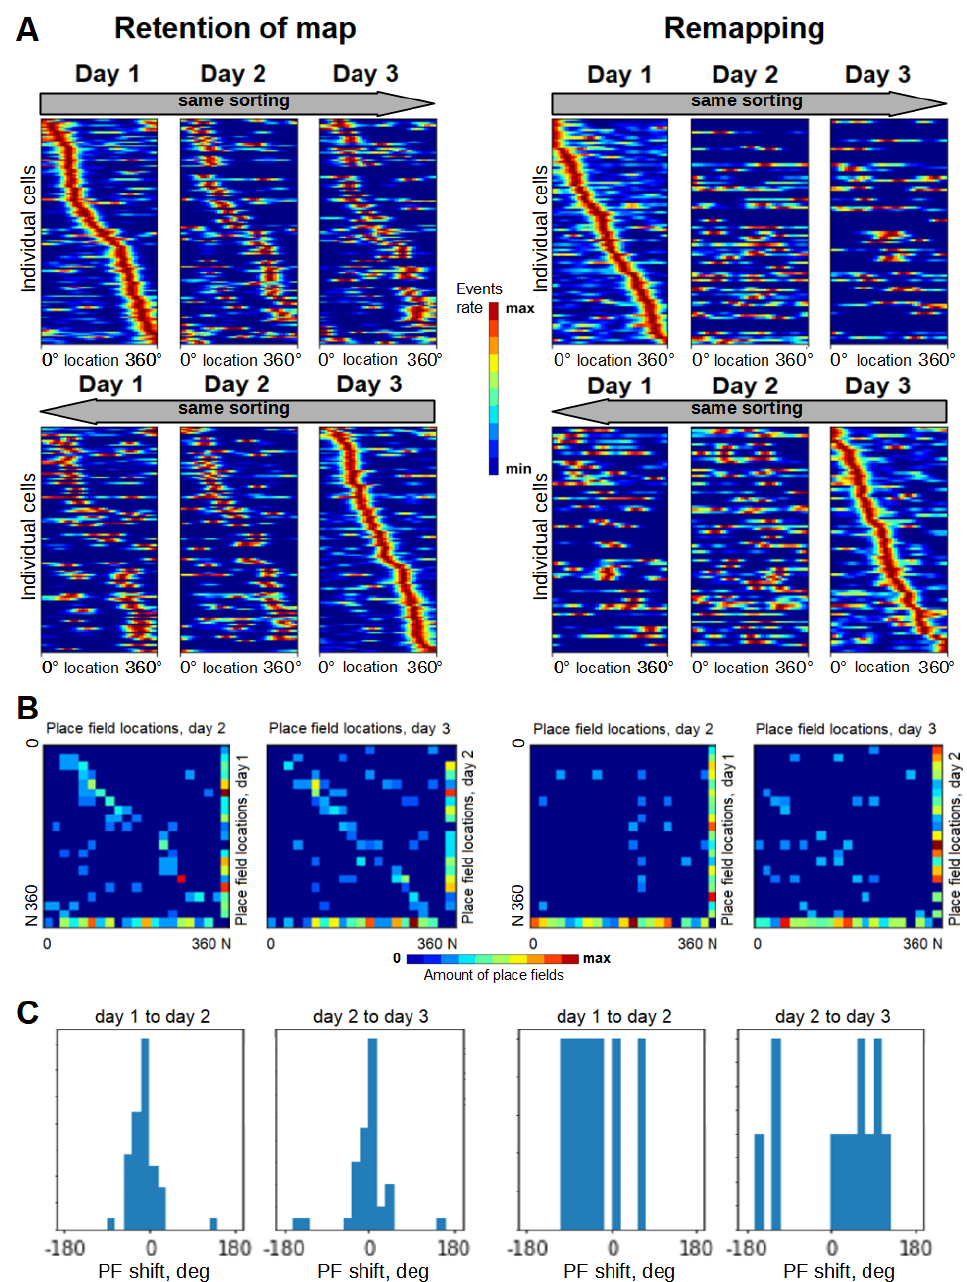
Figure 3. ( A ) Distribution of place fields across days in a case of retained representation (left) and in a case of remapping (right). Each line in a block corresponds to overall activation rate across the track space of each individual place cell in three consequent sessions. Upper row: cells sorted by their peak firing locations on the 1st day. Lower row: cells sorted by their peak firing locations on the 3rd day. ( B ) Heat maps of place cells that changed their place field locations between days. Multiple place fields of the same place cell are scored as fractions. N, not a place cell. Between-day transitions with the retention of the map result in heat maps with distinct diagonals, while remapping transitions do not. ( C ) Distribution of place field shifts for single-place-field place cells (between 1st and 2nd days and between 2nd and 3rd days). Between-day transitions with the retention of the map show sharp peaks in such distributions while remapping transitions show uniform